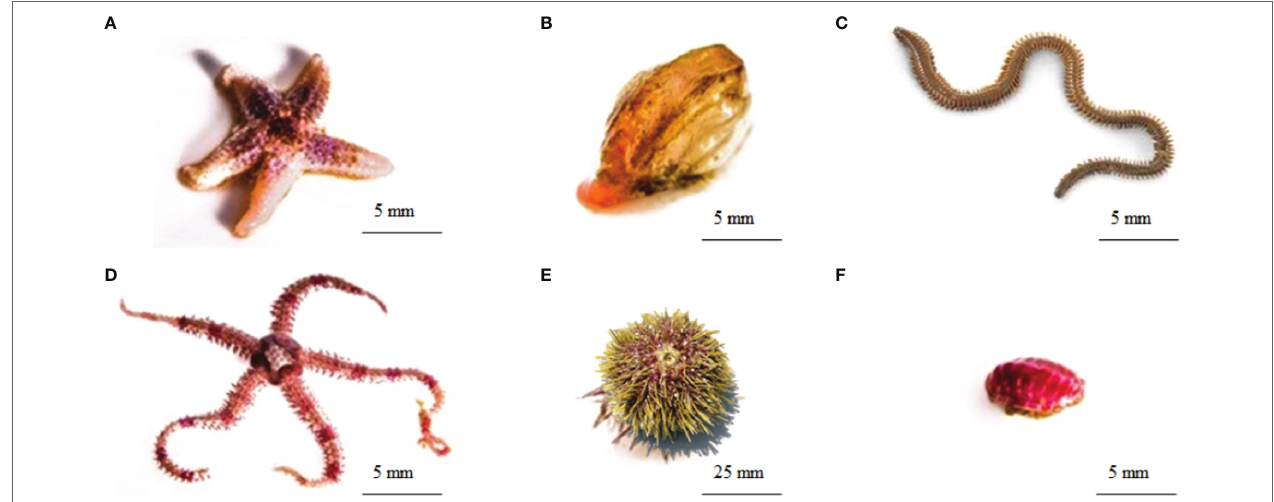
FIGURE 2 | The six animal species included in the present study’s food web analyses; (A) common sea star, Asterias rubens ; (B) wrinkled rock-borer, Hiatella arctica [bivalve]; (C) Nereis spp. [polychaete]; (D) daisy brittle star, Ophiopholis aculeata ; (E) green sea urchin, Strongylocentrotus droebachiensis and (F) Atlantic red chiton, Tonicella rubra (Images: (A, B, D, F) - Sean Hacker Teper; (C) https://www.enasco.com/p/Sandworm-Clam-Worm-Nereis%2C- Preserved%2BLS01292; (E)